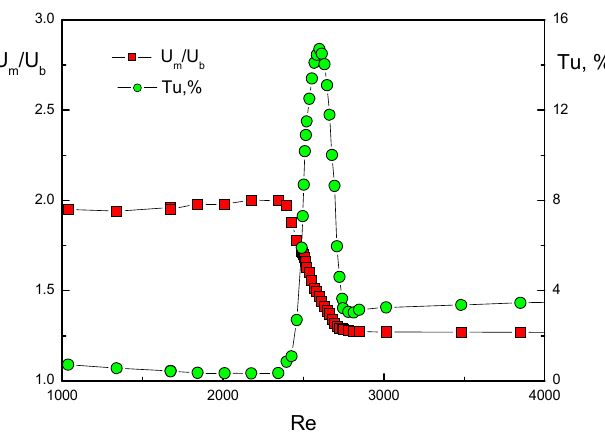
Figure 2. Velocity and velocity pulsations in the initial section of the CO 2